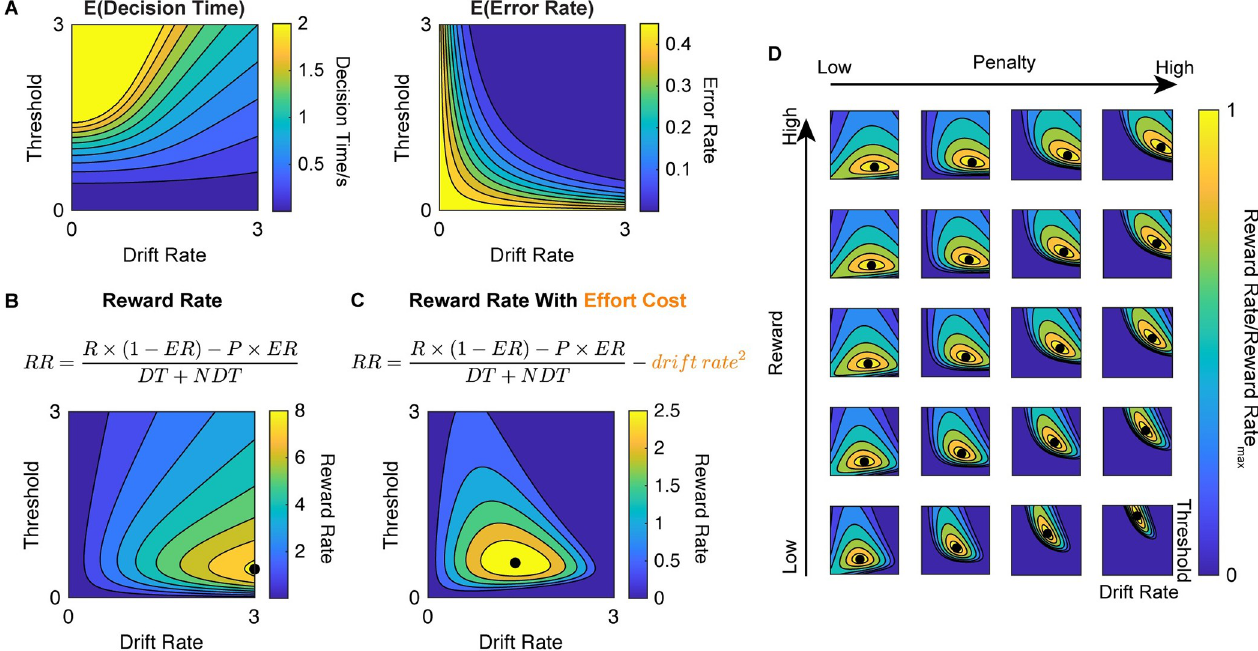
Fig 3. The influence of DDM parameter settings on estimates of reward rate. (A) The expected error rate ( ER ) and decision time ( DT ) can be estimated as a function of drift rate and threshold. (B-C) Reward rate is traditionally defined as a function of expected error rate, scaled by the value of correct vs. incorrect responses, and the overall response time (the combination of decision time and decision-unrelated processes [31]). The combination of drift rate and threshold settings that maximizes reward rate (black dots) differs depending on whether drift rate is assumed to incur an effort cost or not. (B) Without a cost, it is always optimal to maximize drift rate. (C) With a cost, drift rate and threshold must both fall within a more constrained set of parameter values. Reward rate isolines in (B-C) are defined at Subjective Reward = 5, Subjective Penalty = 5, non-decision time = 400ms. (D) As the subjective reward for each correct response increases (plotted from 8 to 20 a.u.), the optimal joint configuration of drift rate and threshold (black dot) moves primarily in the direction of increasing drift rate. As the subjective penalty for an incorrect response increases (plotted from 5 to 625 a.u.), this optimal configuration moves in the direction of increasing